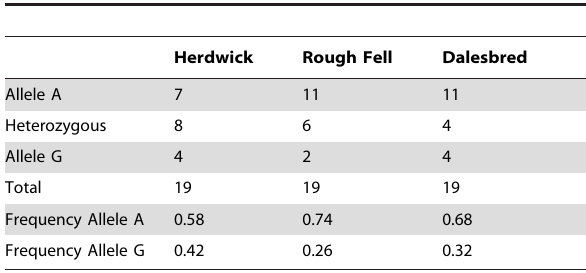
Table 2. Genotype classes and frequencies of alleles for SNP locus (MV lentiviral susceptibility).